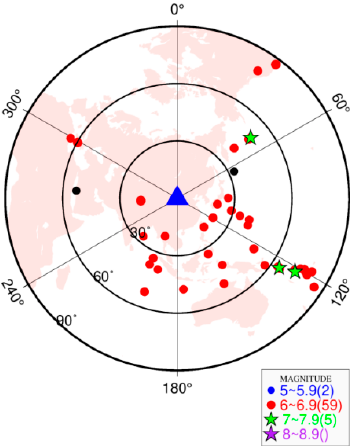
Figure 10. Only teleseismic events 30–90° away from the array are selected.